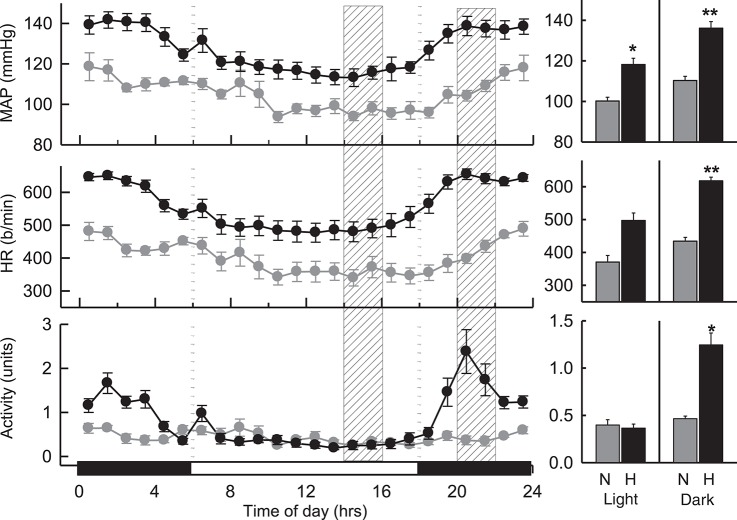
Hourly averaged data showing the circadian variation of MAP (mmHg), HR (beats/min) and activity (units) during the dark (active) (outer panels) and light (inactive) (Middle) phases in BPN/3J (n = 7) and BPH/2J mice (n = 8). Shaded columns represent time-range of conduct of light (inactive) experiments (Left) and dark (active) experiments (Right). Bar graphs on right represent average MAP, HR, and locomotor activity during the light (inactive) and dark (active) periods in BPN/3J (N) and BPH/2J (H) mice. Values are mean±SEM. For comparisons between strains across the 12 hr light or dark period. *P < 0.05; **P < 0.01.